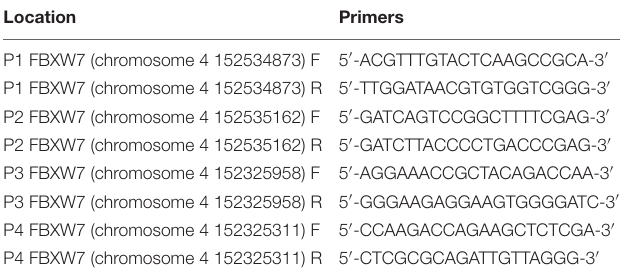
TABLE 4 | Primers used for the RT-qPCR.